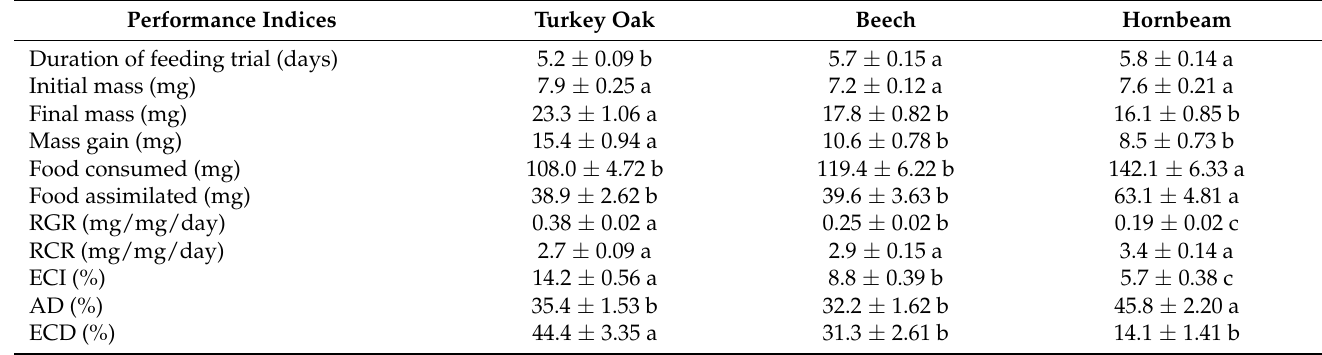
Table 3. Performance indices (mean ± SE) for 4th instar GM larvae depending on host plant. After one-way ANOVA (see Table 4) or ANCOVA (see Table 5) data were compared by Tukey HSD post hoc test and significantly different values were marked by different letters within a row ( p < 0.05).